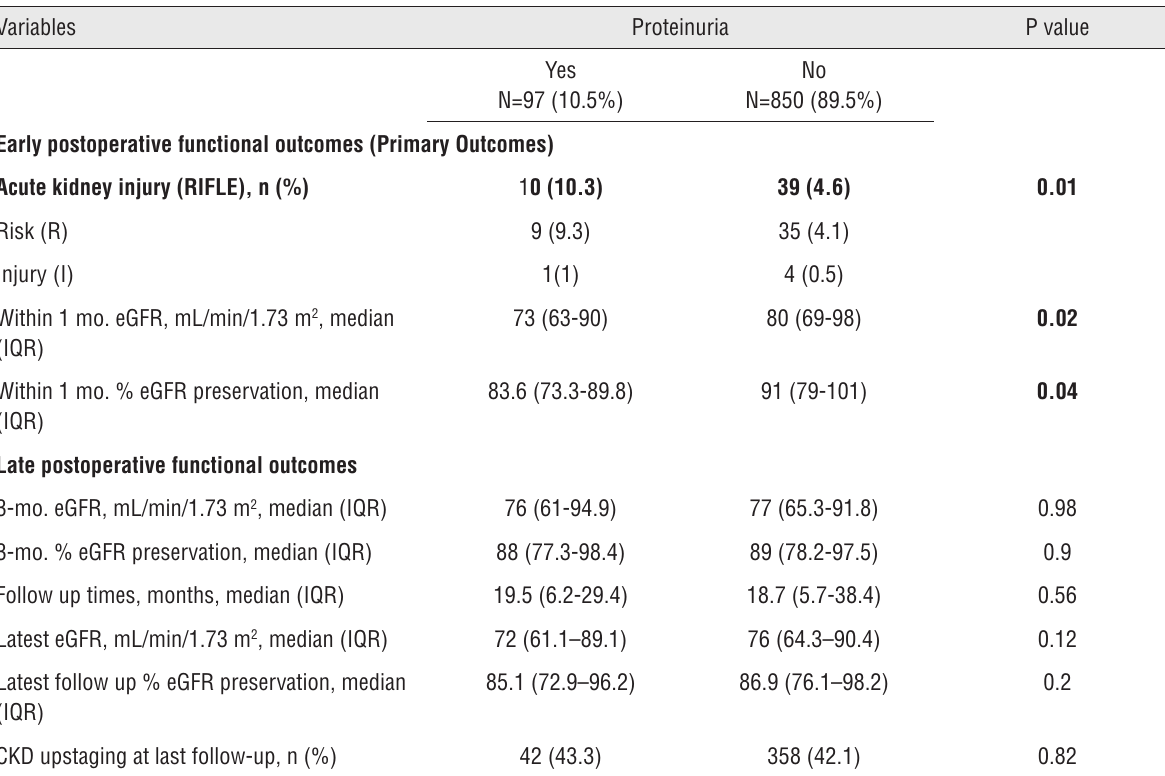
Table 2 - Follow-up functional data.